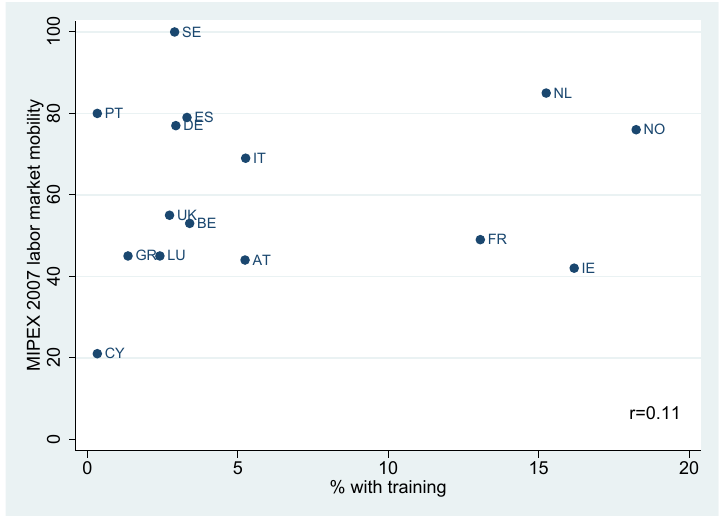
Figure 1: Proportion of immigrants who participated in training and countries’ MIPEX of labor market mobility.